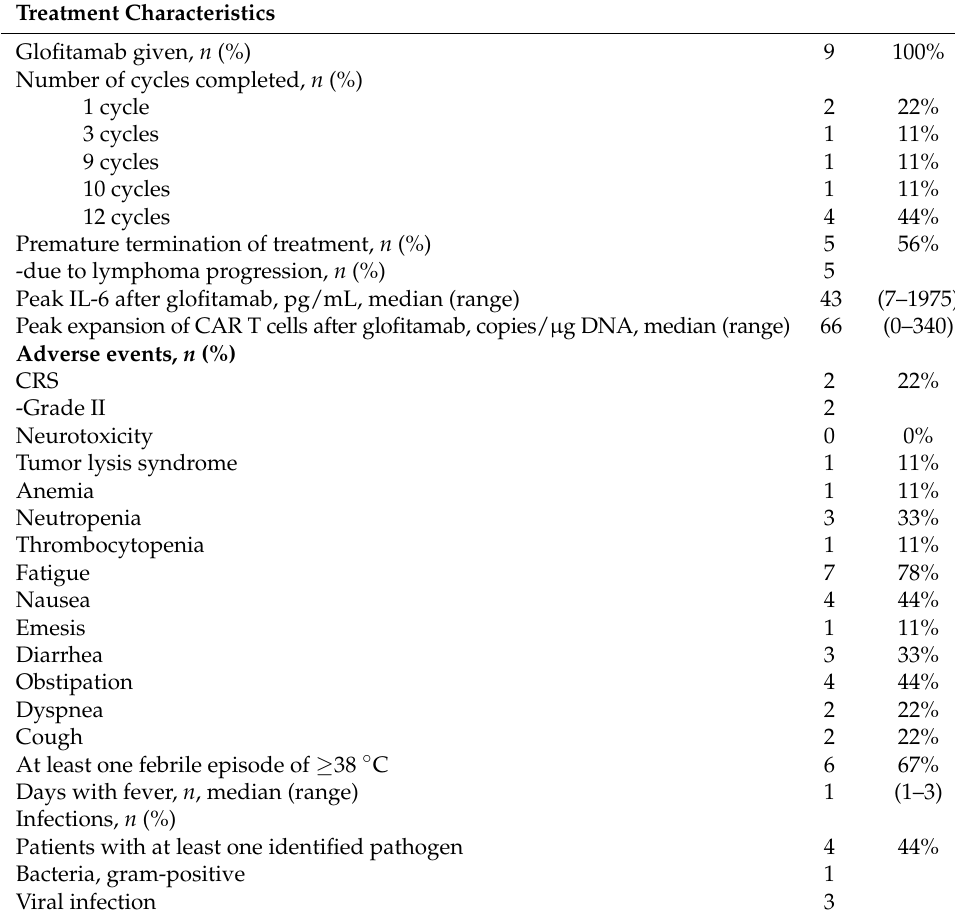
Table 3. Glofitamab treatment characteristics and adverse events. Treatment